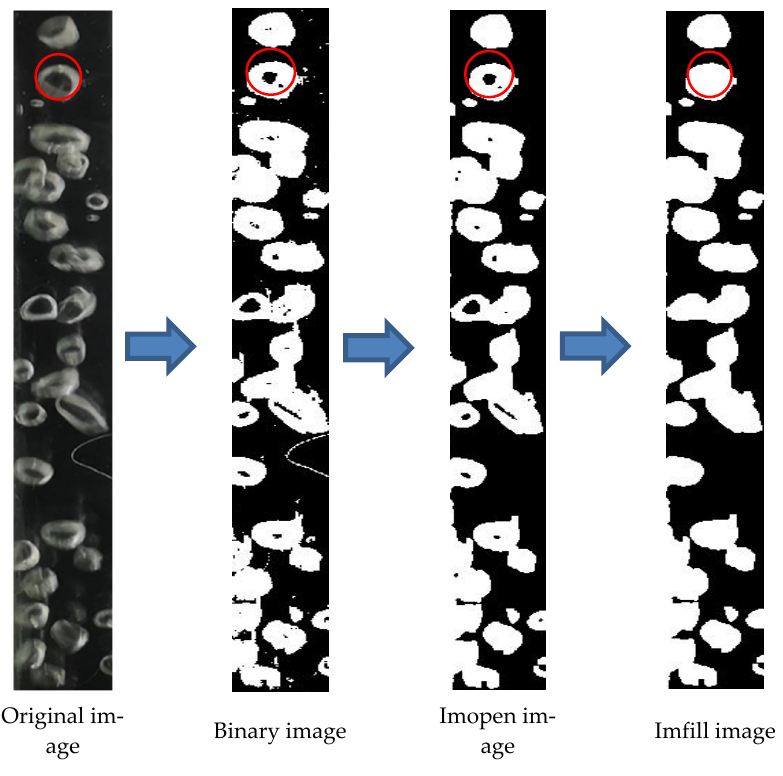
Figure 2. Image processing process.